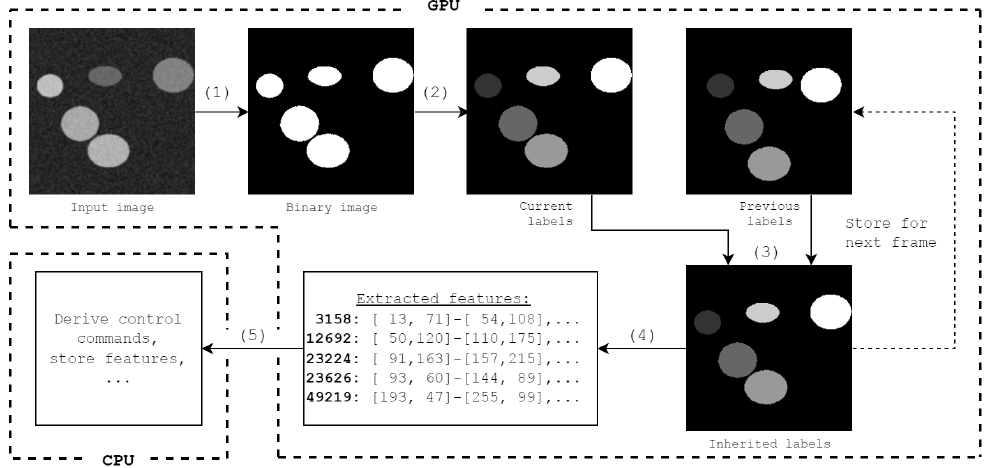
Figure 1. Data processing steps for connected component analysis to realize object tracking using UFXCT: (1) binarization, (2) initial connected-component labeling, (3) label inheritance, (4) connected- component analysis, and (5) feature analysis on